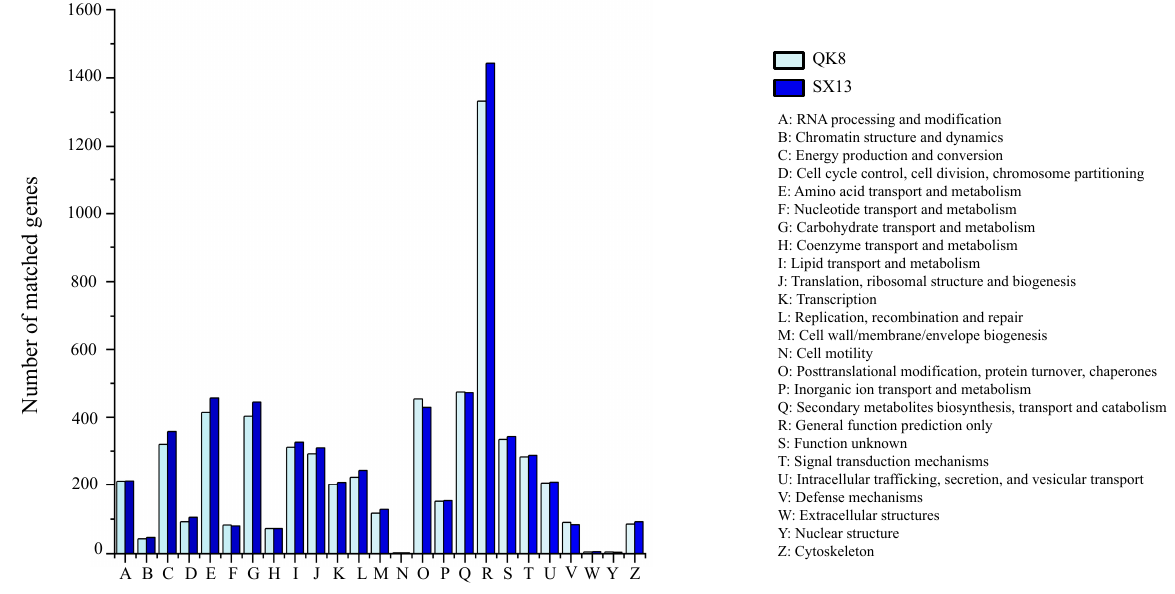
Figure 3. KOG functional classification of strains QK8 and SX13.